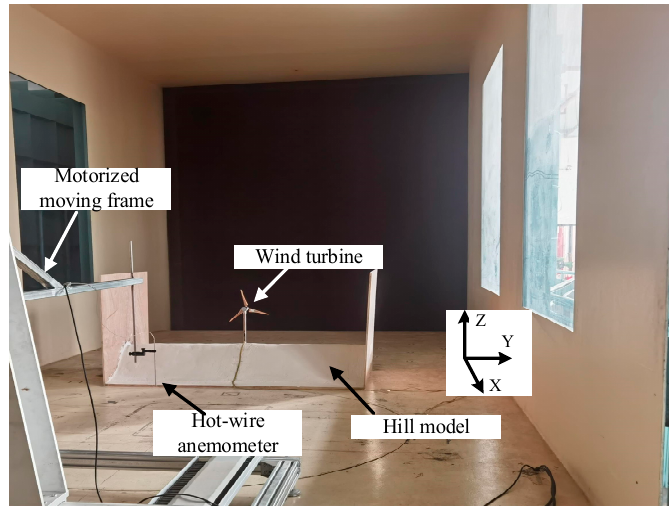
Figure 3. Photograph of the test setup.